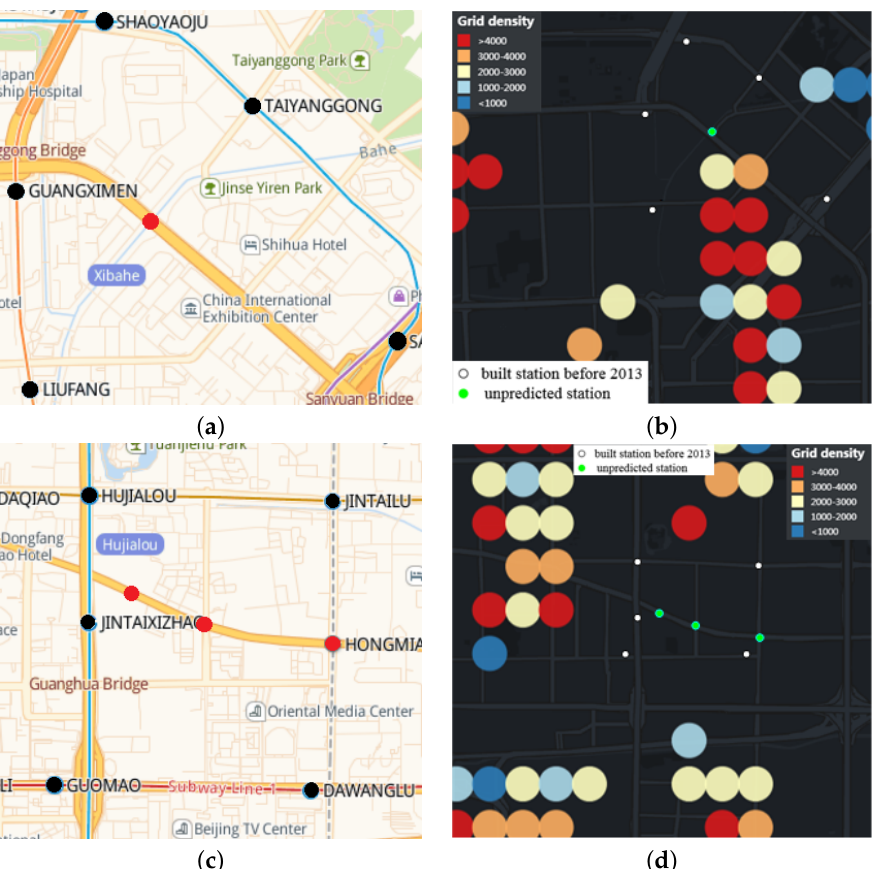
Figure 15. Distribution of built stations around unpredicted stations. ( a ) Xibahe Station; ( b ) Re- lationship between density visualization and Xibahe Station; ( c ) Relationship between density visualization and Xibahe Station; ( d ) Relationship between density visualization and Hongmiao Station, Guanghualu Station and Jingguangqiao